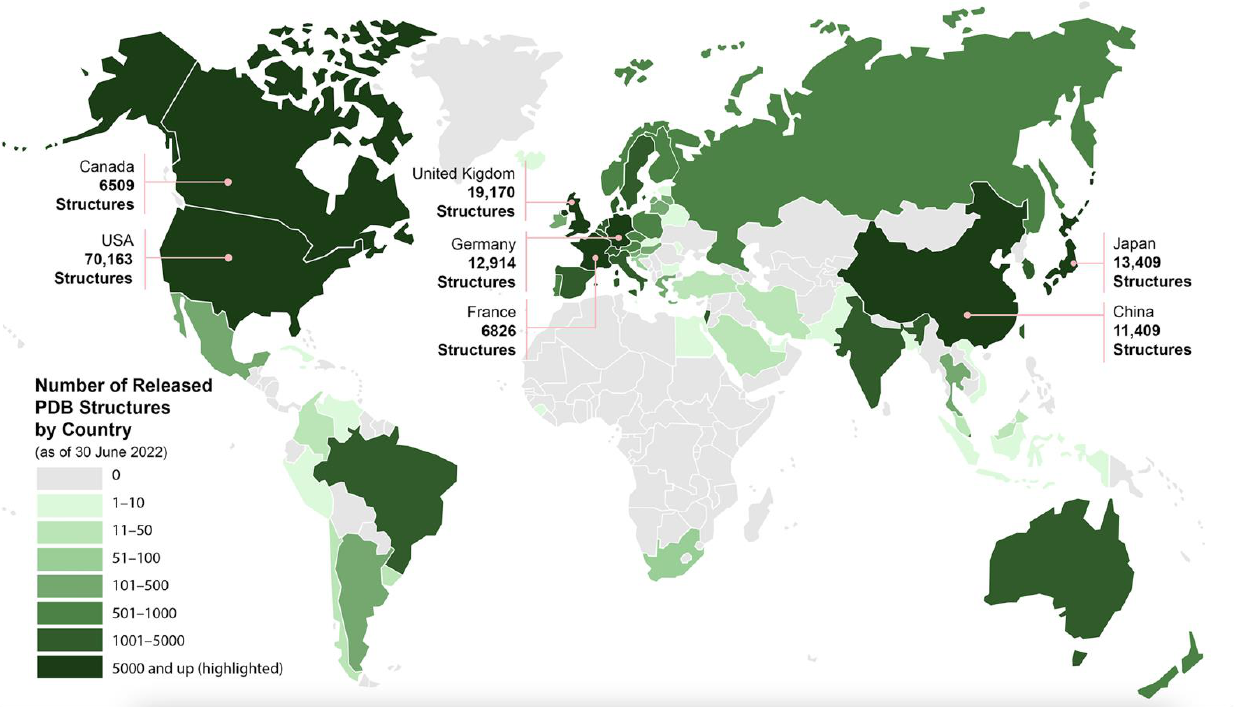
Figure 1. Geographic distribution of PDB depositions from 1971 to mid-2022.